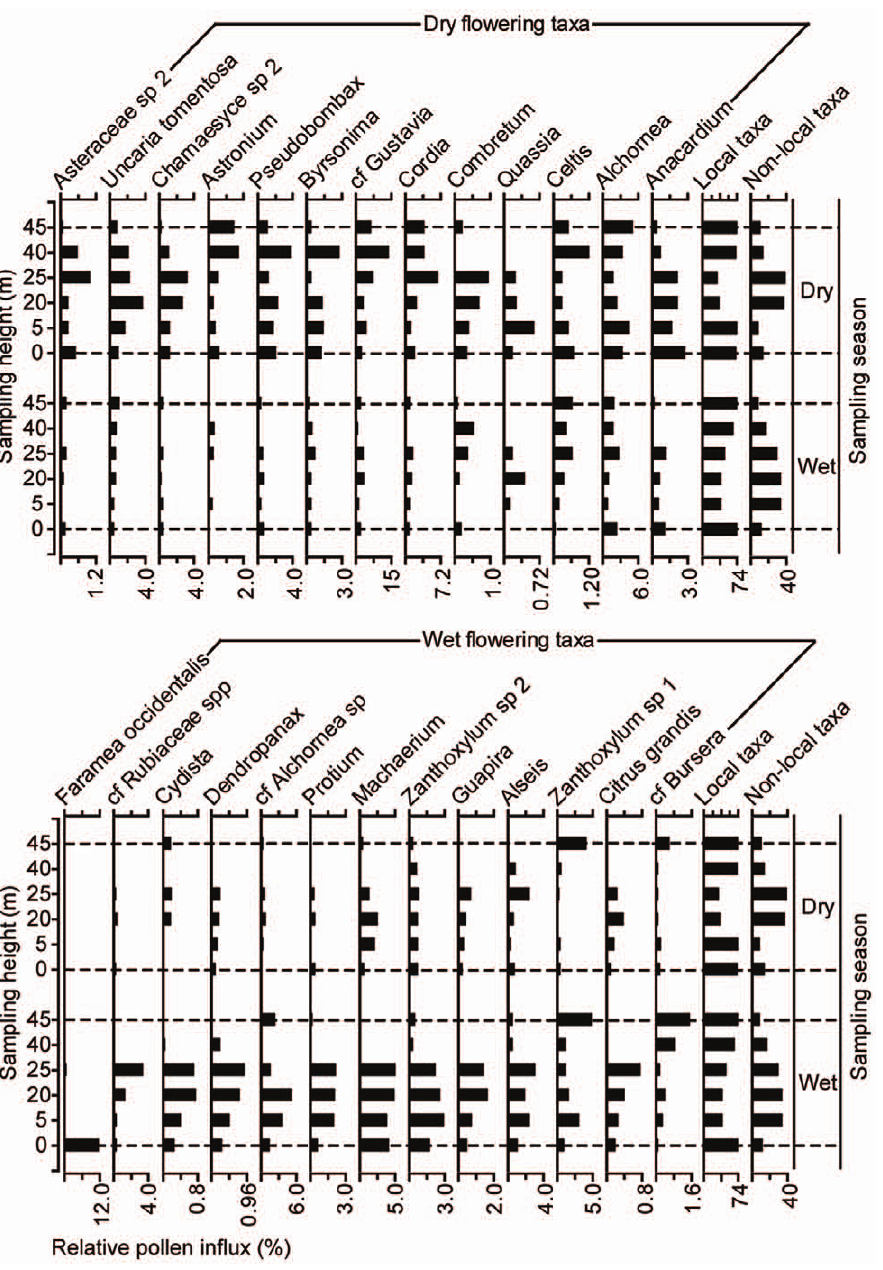
Figure 4. Seasonal pollen influx. Pollen diagram illustrating the compositional variability of the seasonal pollen influx, by sampling height. Pollen taxa exhibiting the most intra-annual variability in abundance over the 10-year pollen rain are graphed as their relative percentage of the total pollen influx for each season from 1996–2005. Influx data from the 1998 pollen samples are excluded because the pollen traps were not collected seasonally. the ordination axes was weak (with eigenvalues for axes one and two 0.134 and 0.086 respectively), taxonomic differences are apparent among the ground-level, mid canopy, and emergent sampling heights. Emergent 40 m (light red) and 45 m (dark red) pollen assemblages formed a tight cluster in the CA ordination, as did 20 m (light green) and 25 m (dark green) canopy pollen assemblages.